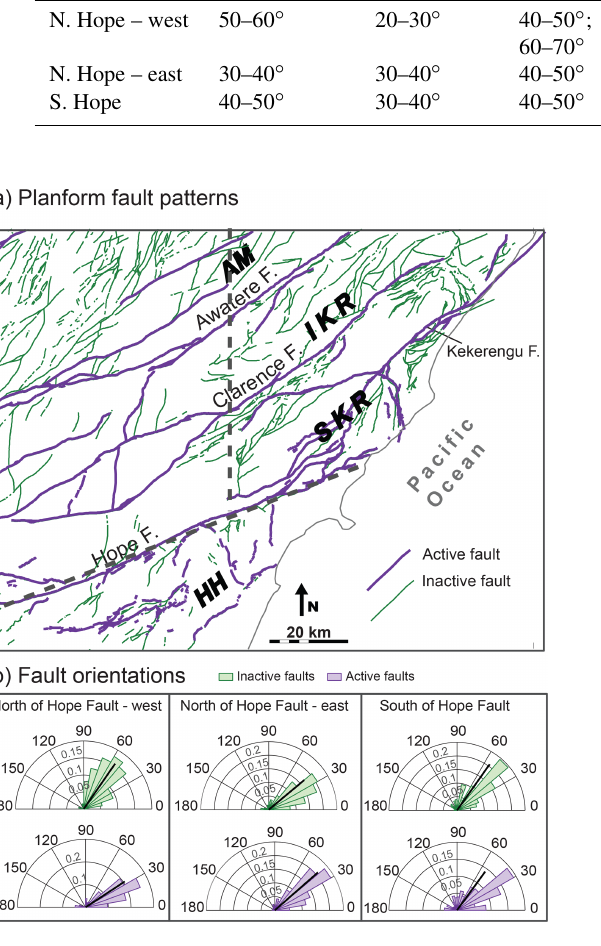
Figure 4. Marlborough Fault System fault patterns across three geomorphic domains. (a) Map of field site faults. Thicker-line- weight faults (purple) are active faults in GNS database. Thinner- line-weight faults (green) are inactive in GNS database. AM – Awa- tere mountains, IKR – Inland Kaik ¯ oura Range, SKR – Seaward Kaik ¯ oura Range, and HH – Hundalee Hills. Dashed black lines show topographic domain boundaries (same as in Fig. 2) (b) Half- dial plots showing orientations of inactive (green) and active (pur- ple) fault segments. Numbers within dials show the portion of seg- ments analyzed. Thin black line shows the circular